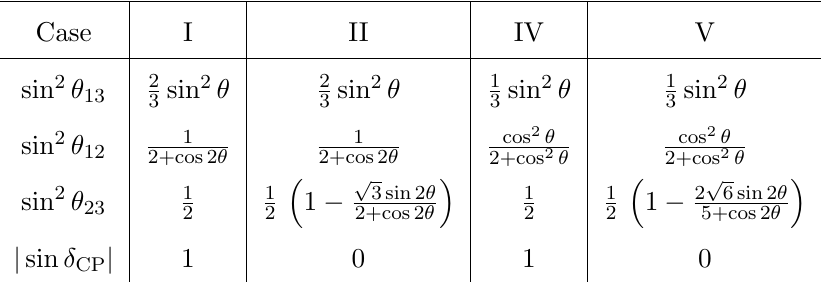
Table 1 . Predictions for the leptonic mixing parameters in terms of the free parameter (cid:18) in Cases I, II, IV, and V originating from G CP = S 4 o CP broken to G e = Z 3 and G (cid:23) = Z 2 ref.